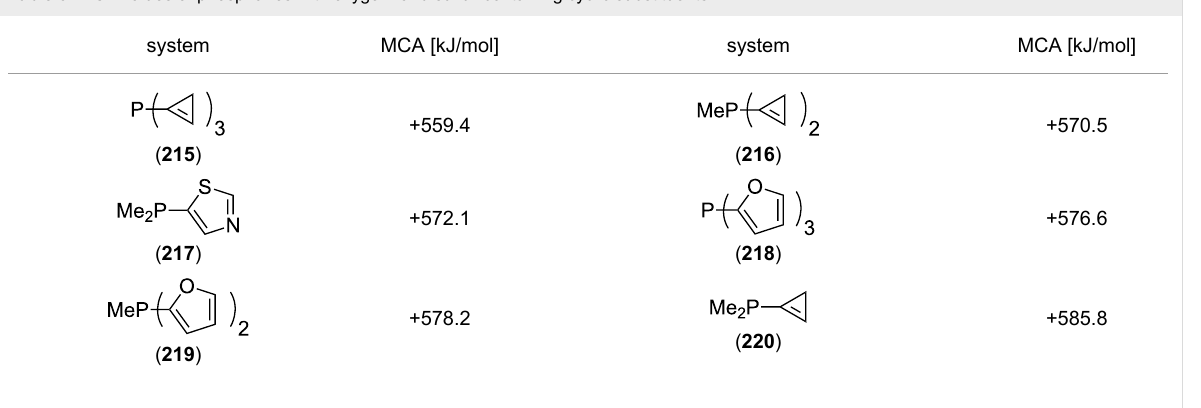
Table 5: MCA values of phosphanes with oxygen- and sulfur-containing cyclic substituents.